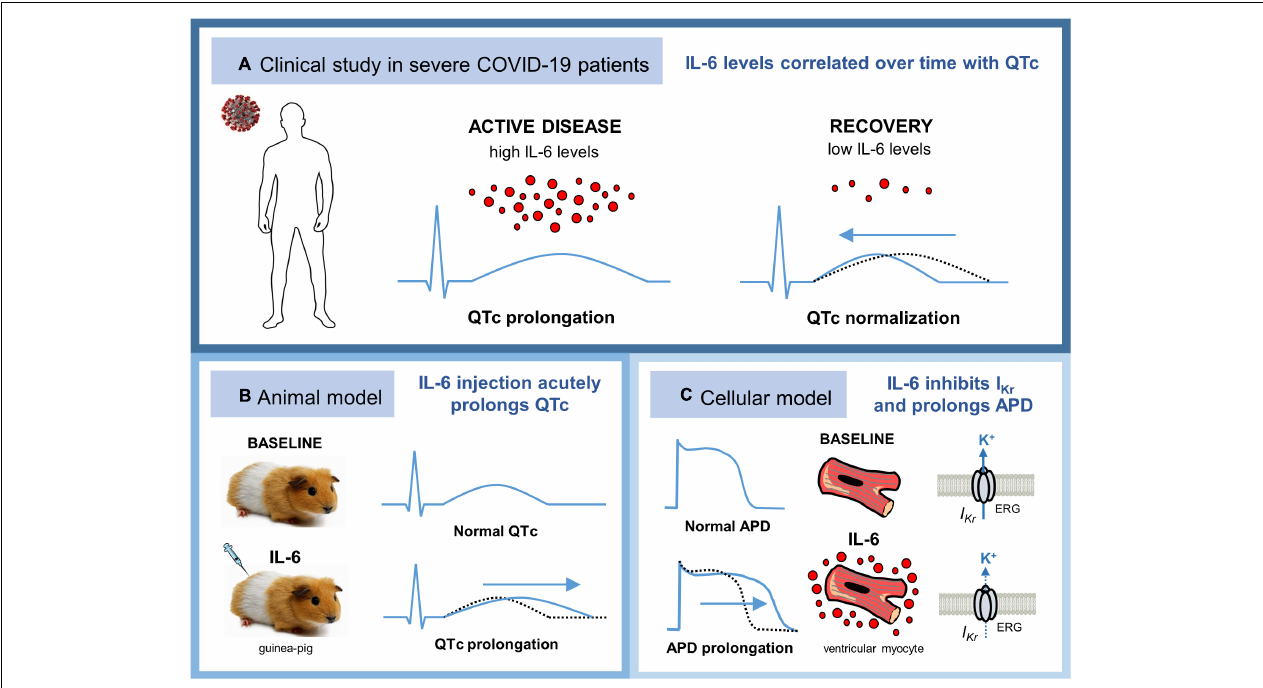
FIGURE 5 | Systemic inflammatory activation may per se promote QTc prolongation in patients with severe COVID-19 via IL-6 elevation, leading to ventricular electric remodeling. (A) In patients with active severe COVID-19 and elevated IL-6 levels, QTc is significantly prolonged but rapidly normalized during recovery in correlation with IL-6 decrease. (B) Direct injection of IL-6 in an in vivo guinea pig model acutely prolongs QTc duration. (C) Guinea pig ventricular myocytes incubated in vitro with IL-6 show evident APD prolongation, along with significant inhibition in the I Kr current. APD, action potential duration; COVID-19, coronavirus disease 2019; ERG, ether-a-go-go-related gene K + channel; IL-6, interleukin-6; I Kr : rapid delayed rectifier potassium current; QTc, heart rate-corrected QT